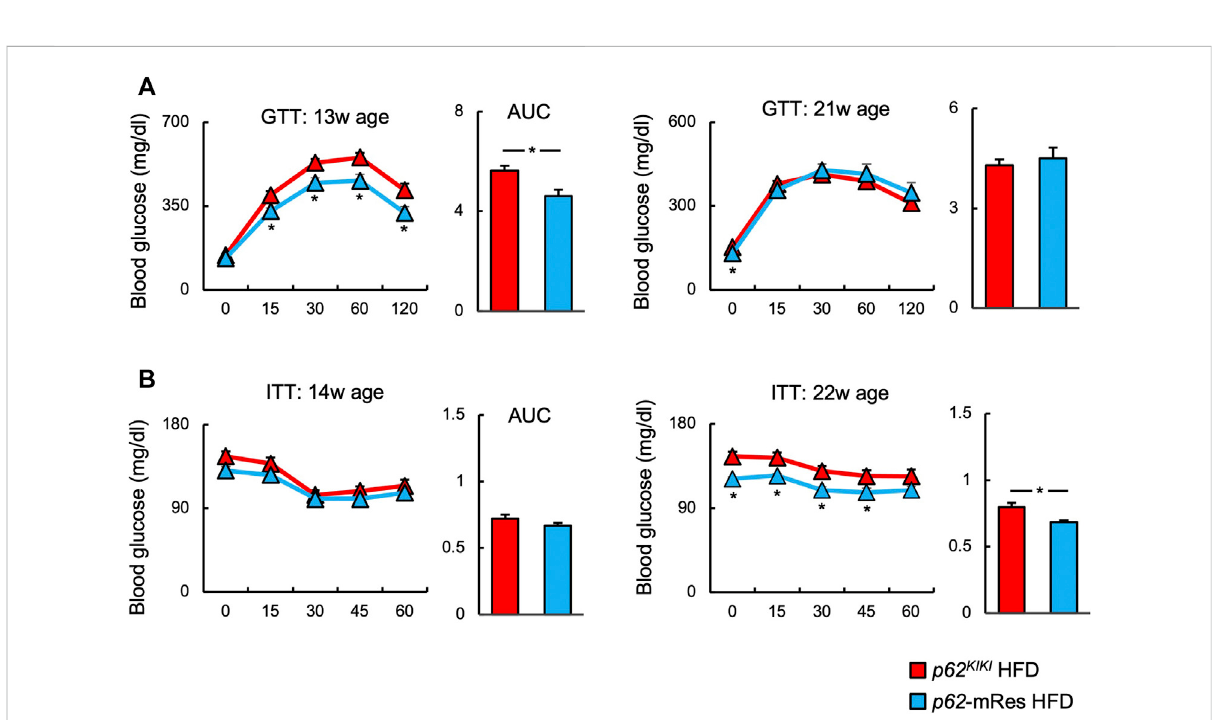
p62in muscle ameliorates obesity-associated glucoseintolerance and insulinresistance. (A) Changesin blood glucose concentration and area under the curve (AUC) during intraperitoneal glucose tolerance testing (ipGTT) at 13 and 21 weeks of age in HFD-fed ( n = 8 – 14/group) mice.